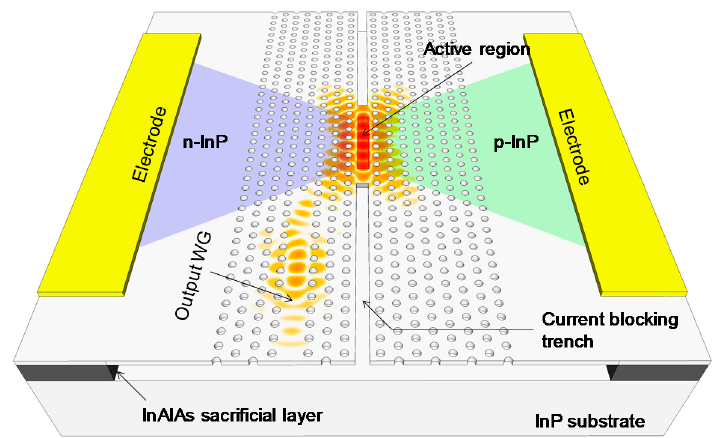
Figure 2. Schematic of a fabricated LEAP laser with a current blocking trench. An optical mode, calculated by the finite-difference time-domain method, is overwritten on the schematic.